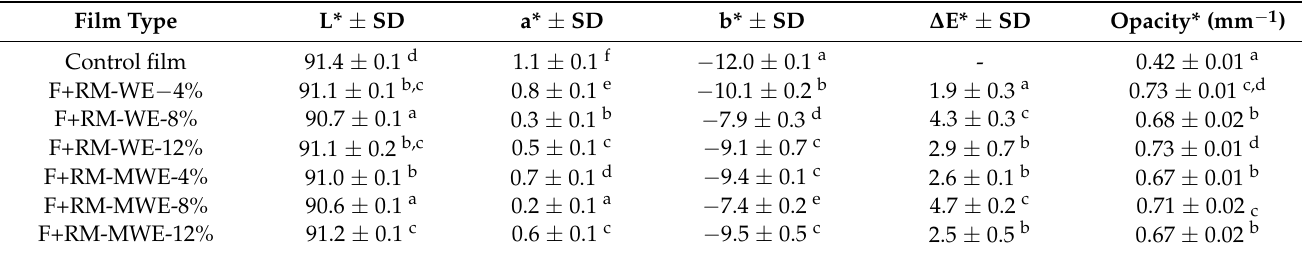
Table 2. Color and opacity properties of the prepared